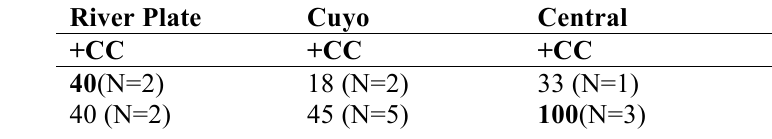
Table 11 . Acceptability of CC with constructions for which CC is